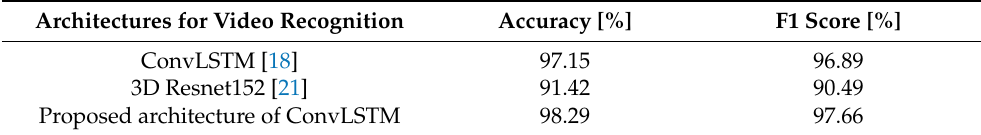
Table 13. Comparison of accuracy obtained by different neural network architectures using the AIRTLab dataset